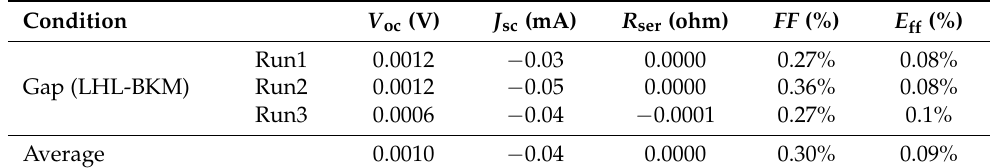
Table 2. The gap in electrical characteristics for solar cells obtained by LHL and BKM diffusion processes.